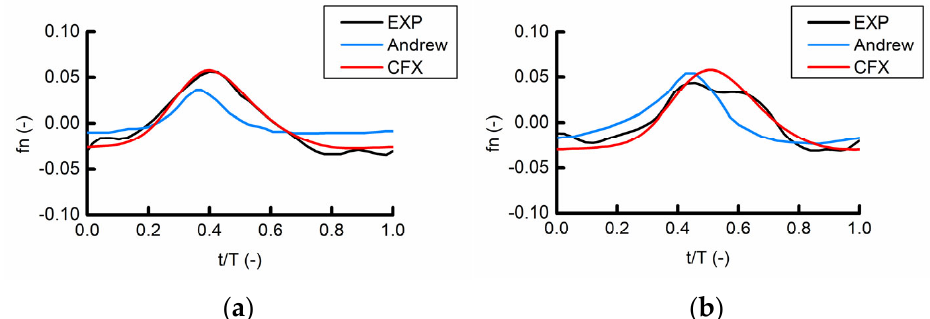
Figure 6. Unsteady force of stator blade. ( a ) Near design condition ( b ) High loading condition.